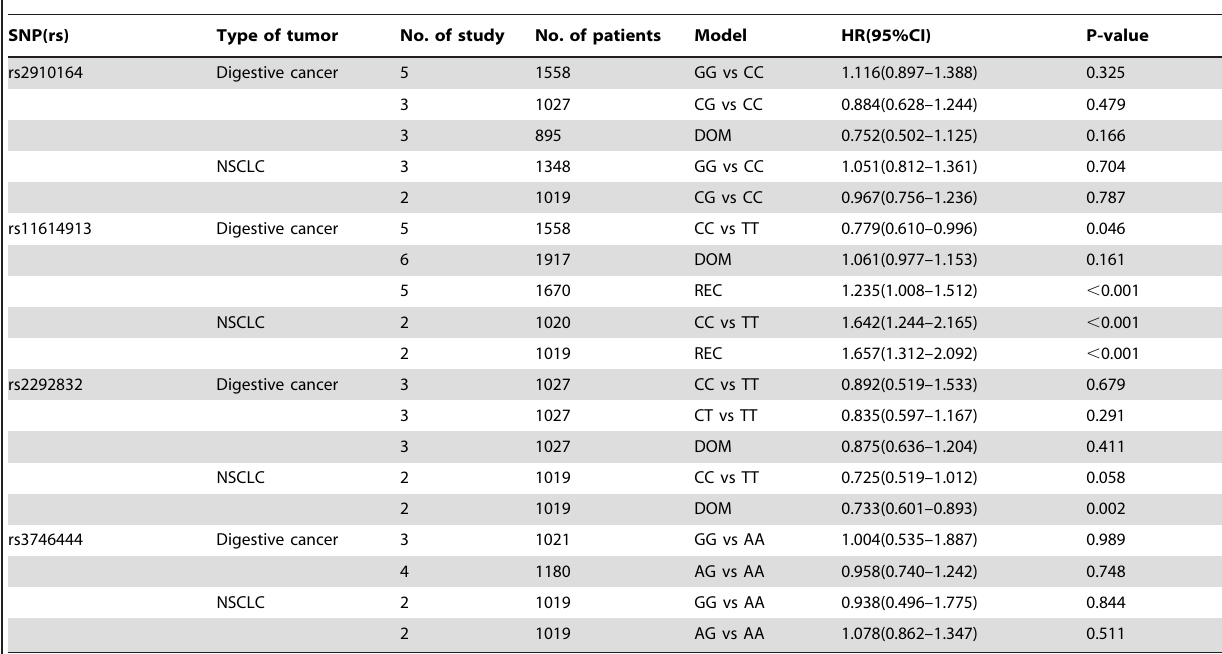
Table 3. Stratified analysis by type of tumor for OS.